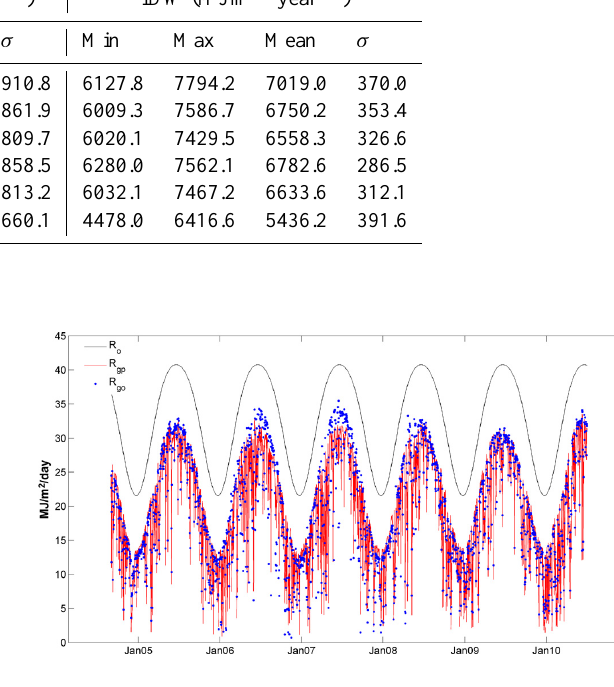
Fig. 5. Extraterrestrial solar radiation ( R o ) , observed ( R go ) ,